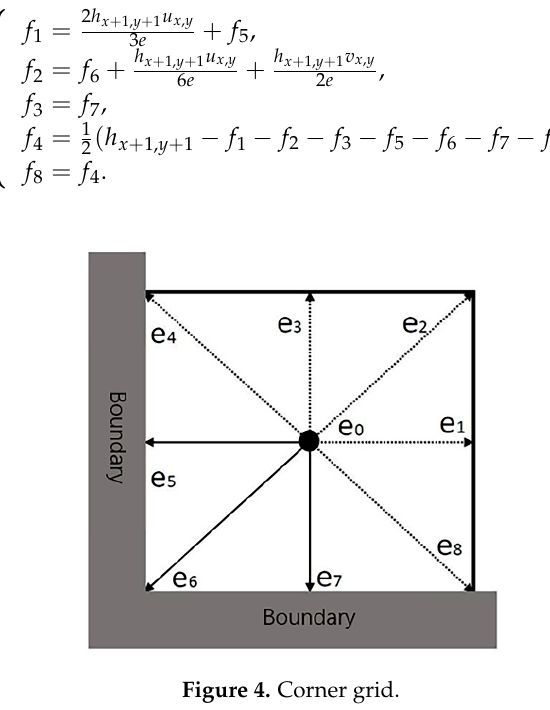
Figure 4. Corner grid.